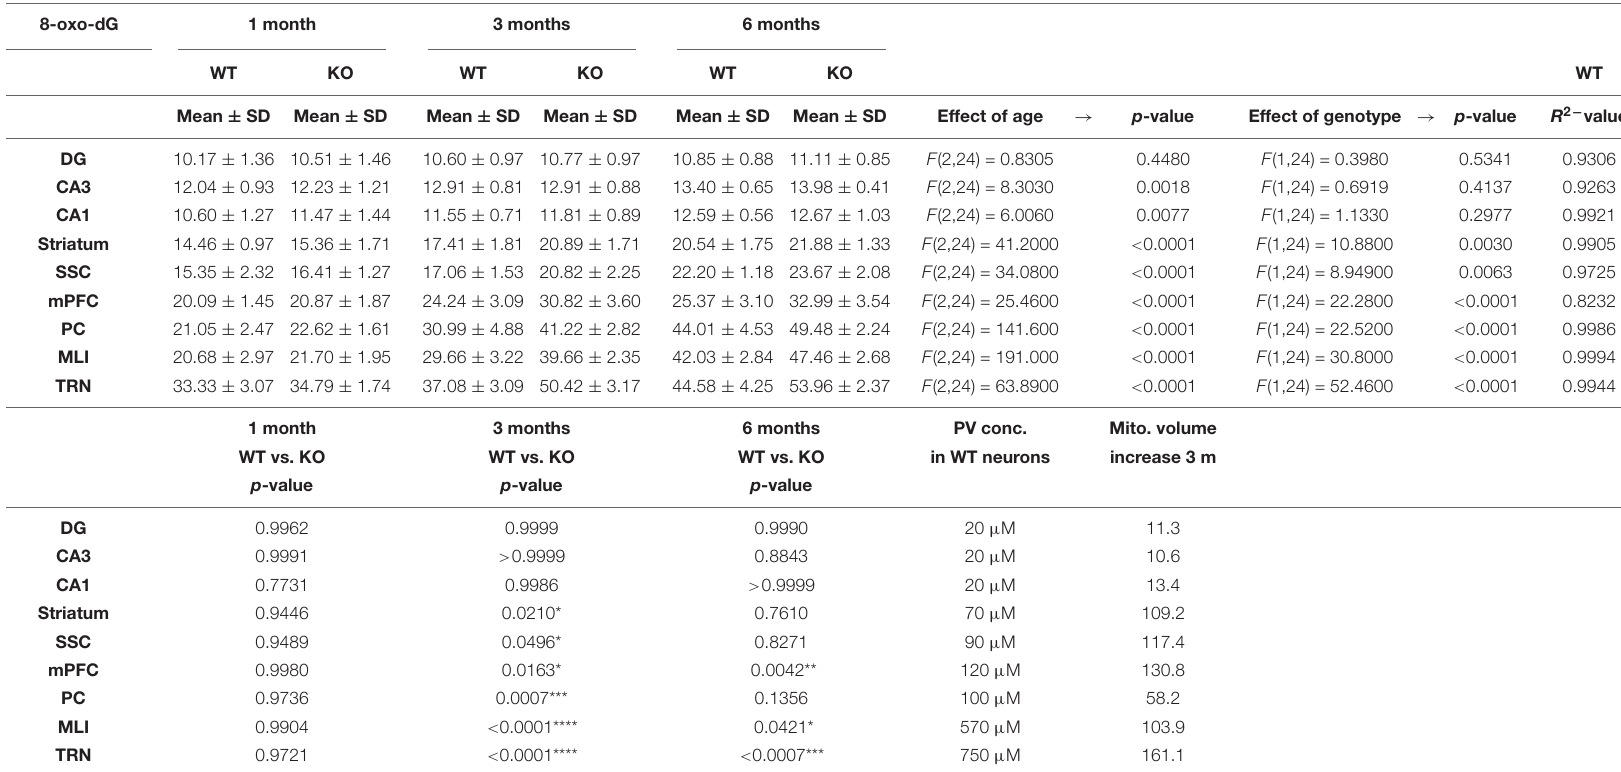
TABLE 1 | Quantitative results and statistical analyses of 8-oxo-dG and DHE staining intensities are shown as mean ± standard deviations in all investigated brain regions.